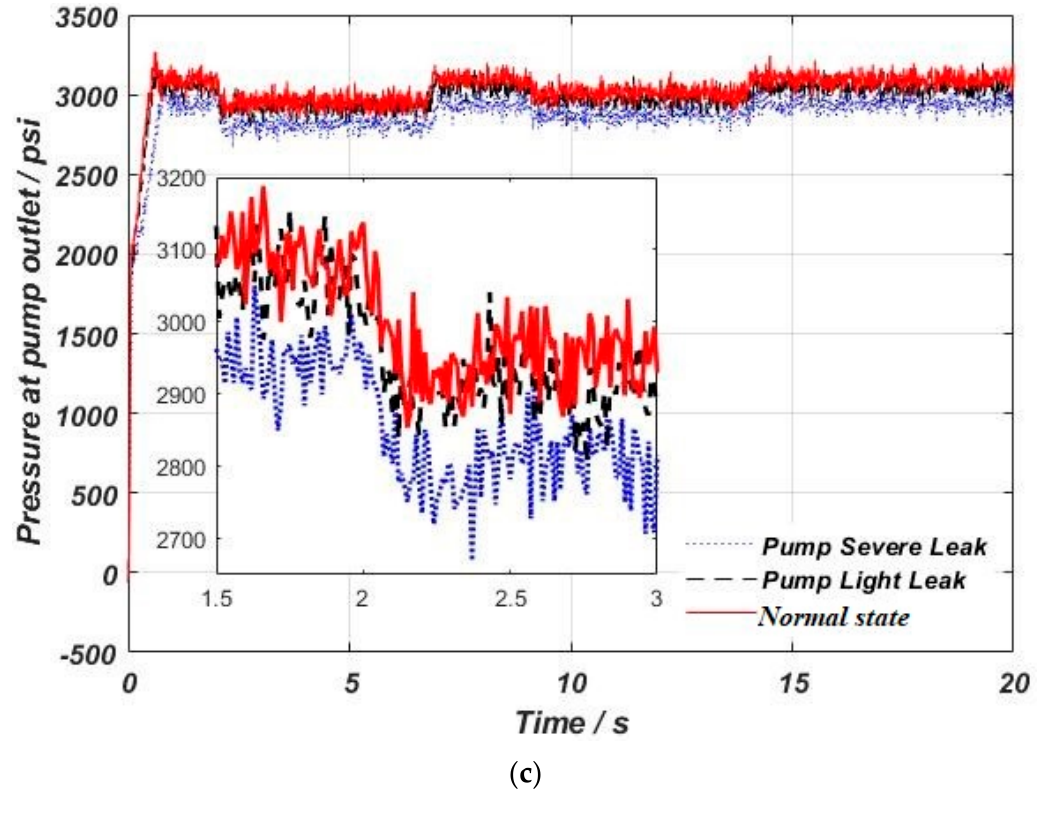
Figure 6. Time domain diagrams for comparing normal status signal with fault status signal. ( a ) Actuator inner leakage. ( b ) Oil pollution. ( c ) Pump leakage. Table 3. Specific parameters and classifications of the generated fault